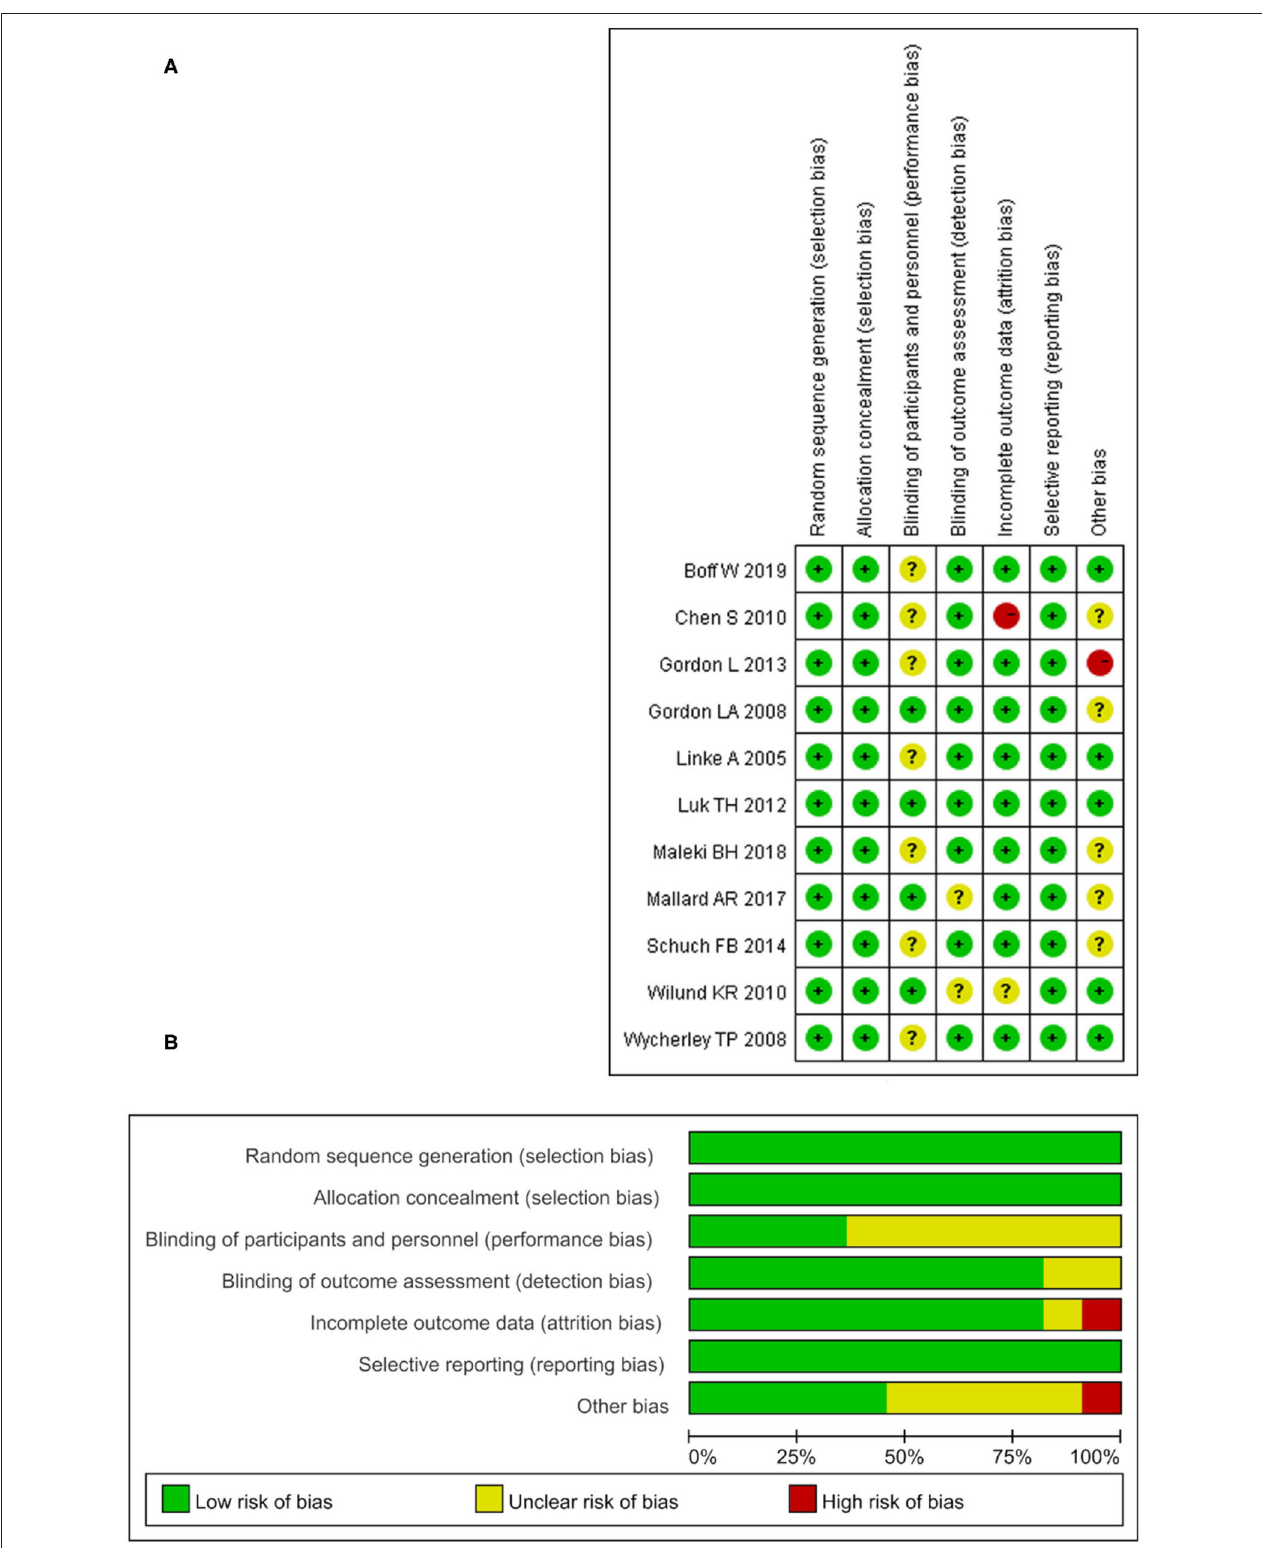
FIGURE 2 | The result of the risk of bias assessment. (A) Risk of bias graph; (B) Risk of bis summary.